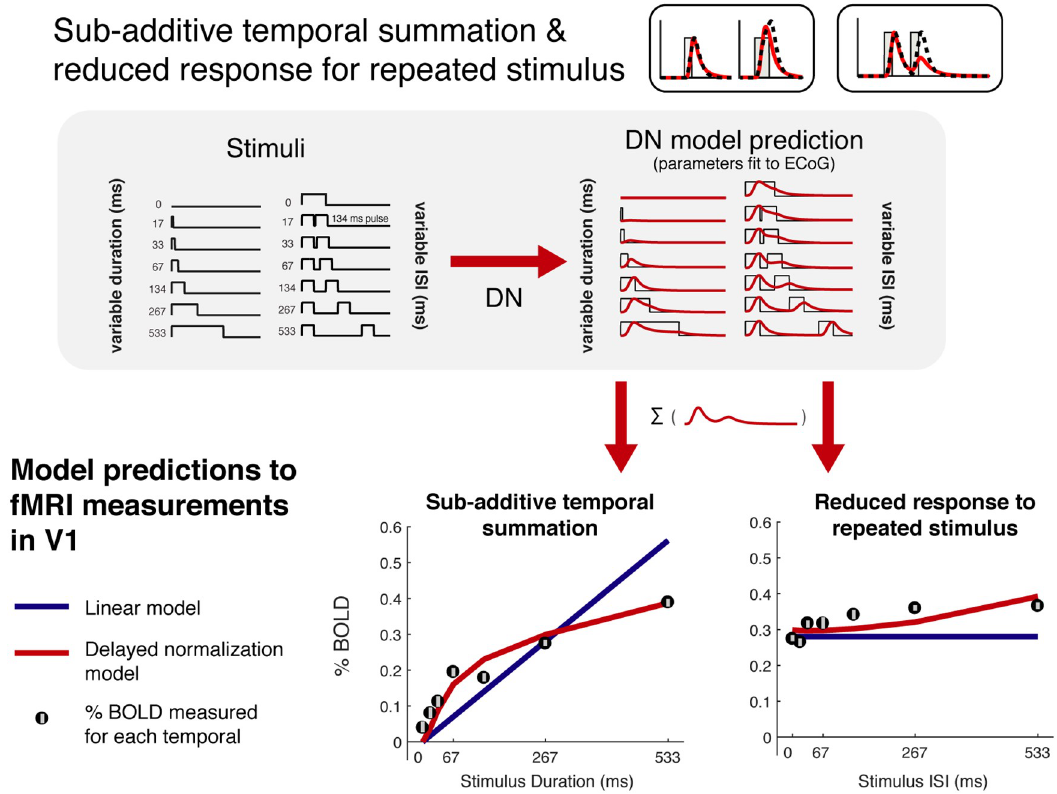
Fig 5. DN model captures sub-additive temporal summation and adaptation. There are two types of temporal profiles used for the fMRI experiment: one-pulse stimuli with varying durations and two-pulse stimuli (134 ms each) with varying ISI. To generate DN model predictions to these stimuli, we used the median DN parameters fit to the V1 broadband time course measured in individual electrodes (S3 Fig). To convert the prediction to percent BOLD, we summed the predicted time course for each temporal profile and fit a single gain factor to minimize the difference between the predictions and the fMRI data. The DN model predictions (red) better capture the BOLD data than the linear prediction (green) (r 2 : 0.94 vs. 0.81).